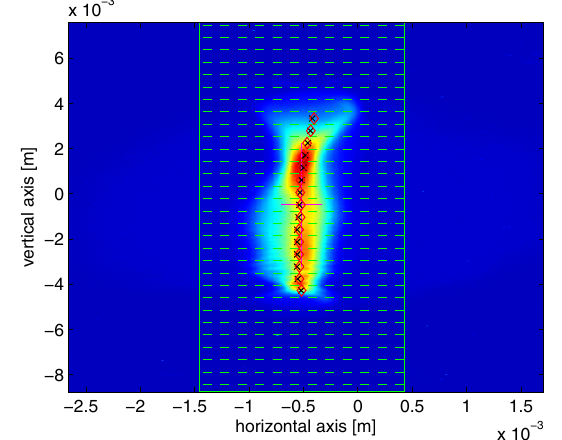
FIG. 6. Typical image of the deflected beam at the transverse profile monitor. The streak correlates the vertical with the longitudinal direction, and the slice emittance is reconstructed in the horizontal plane. Around the centroid (magenta cross) a region-of-interest is defined (green box), which is further divided into slices (dashed green lines). Centroid positions within each slice are calculated (red diamonds) and compared with the center of a Gaussian fit (black crosses).